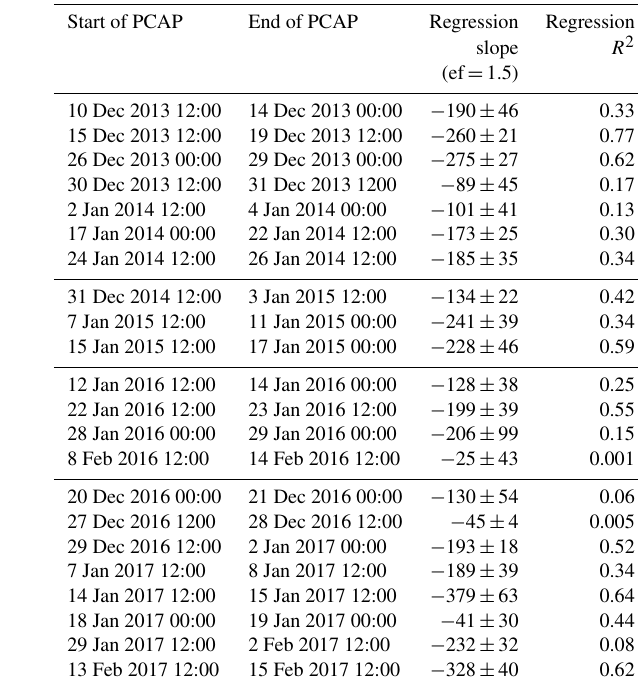
Table 3. Miller–Tans regression parameters for each PCAP